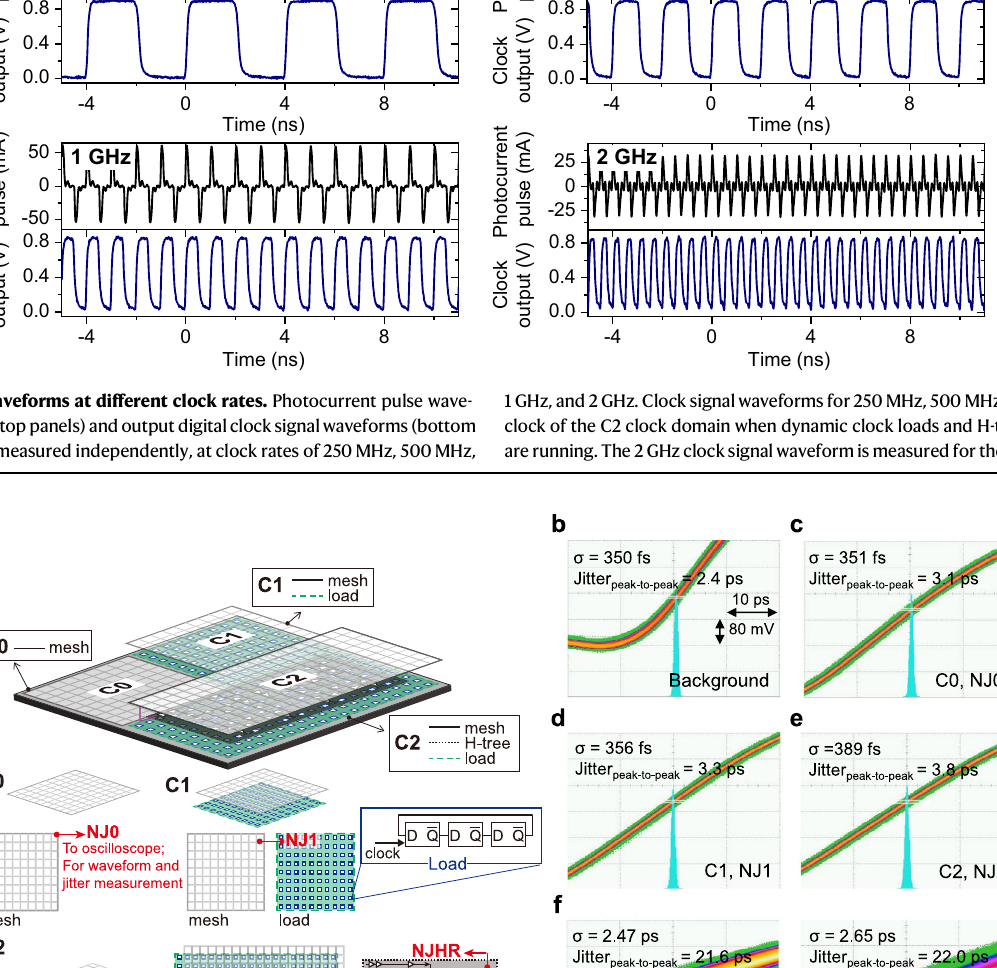
driver in the test chip. Standard deviation and peak-to-peak jitter values were extracted from 100,000-hit-count histograms of the signal crossing at half maximum